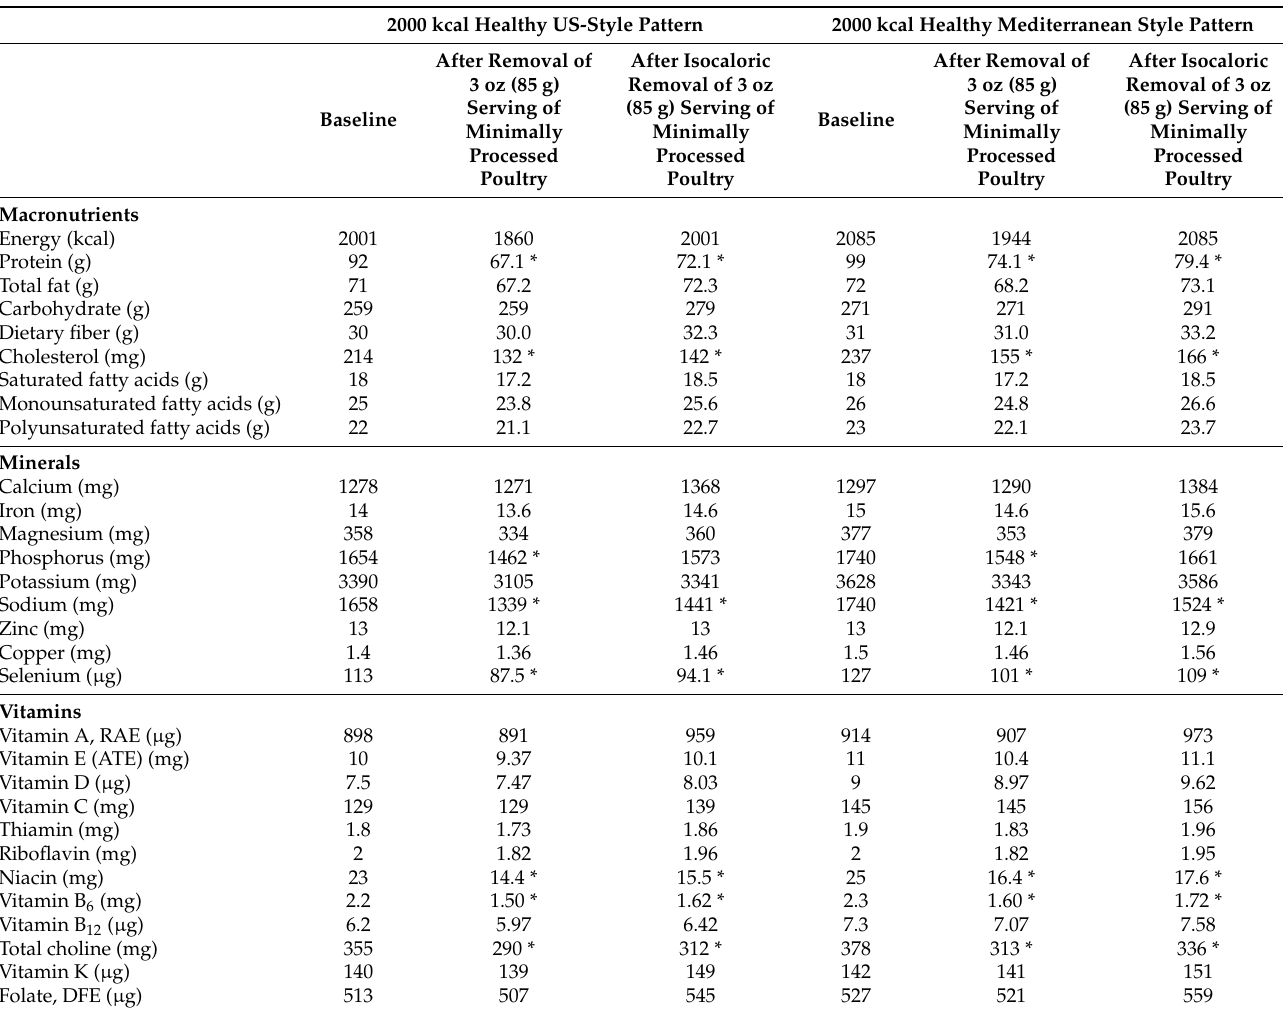
Table 5. Energy and nutrients in 2000 kcal Healthy Dietary Patterns before and after removal of a 3 oz (85 g) serving of minimally processed